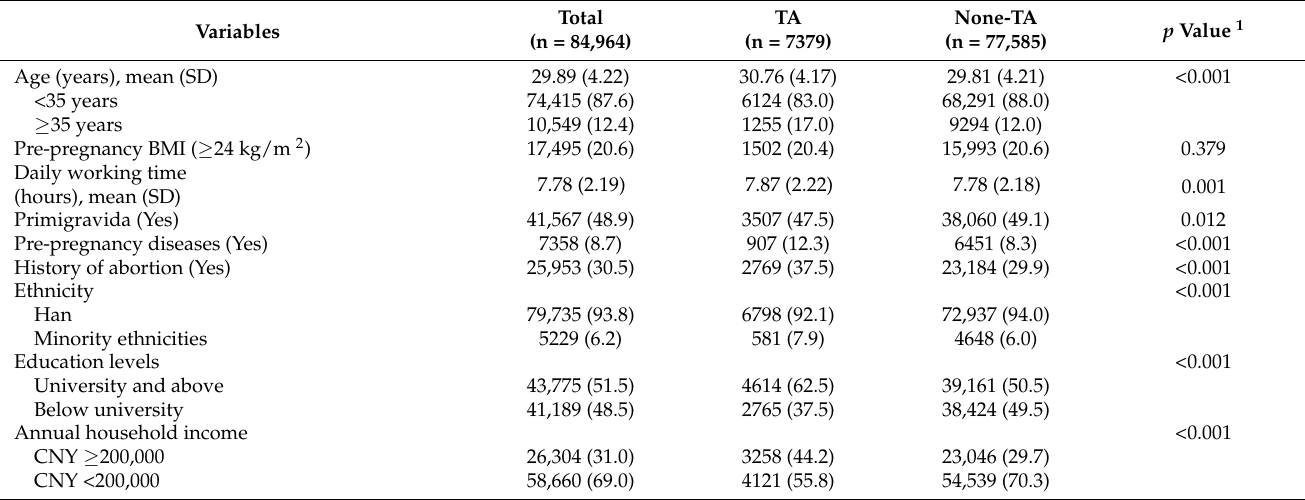
Table 1. Characteristics of study participants (n =